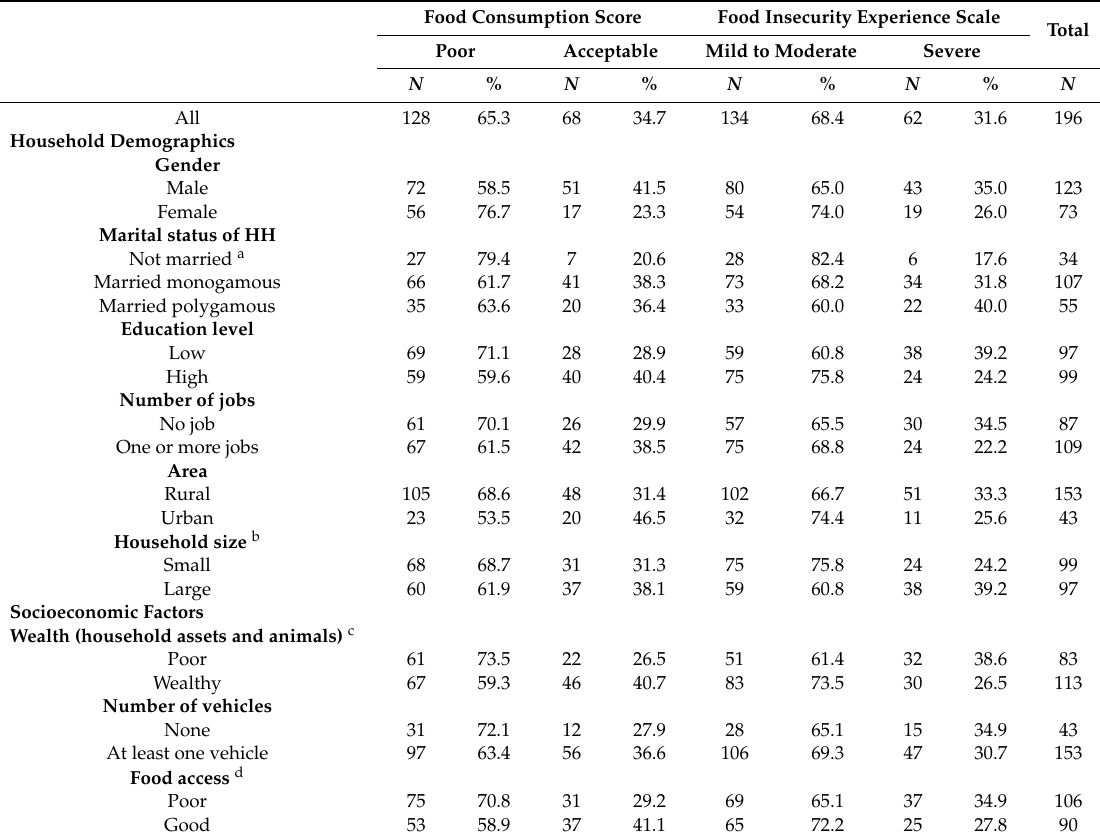
Table 2. Proportion of food consumption and food insecurity experience scale according to demographic and socioeconomic factors.